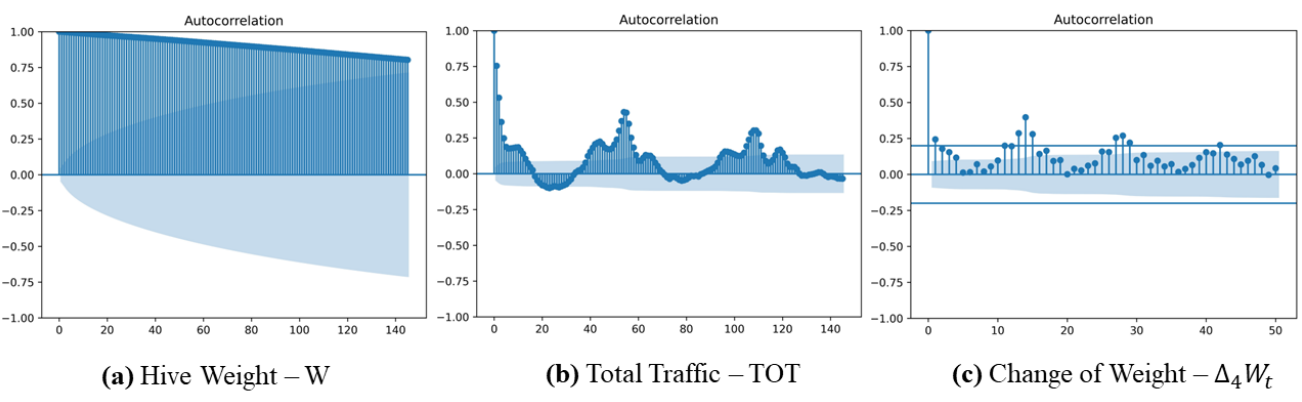
Figure 2. The plots for the other hives are in the supplementary materials (Figures S3–S7).